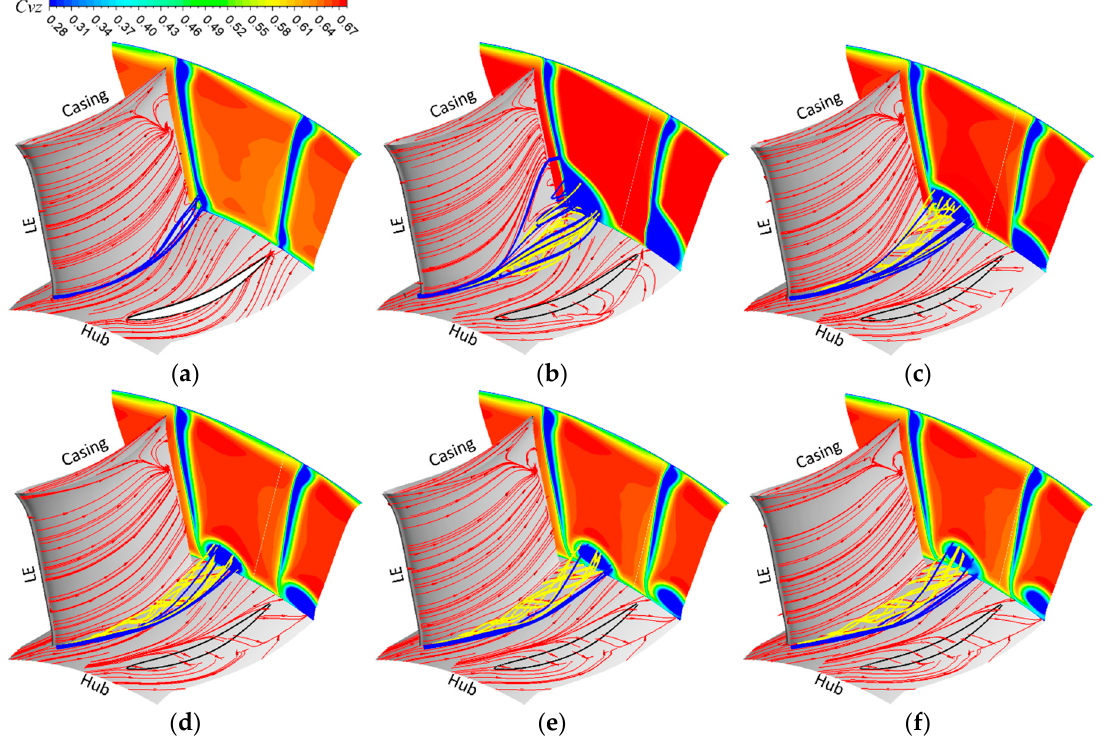
Figure 9. Three-dimensional flow structures inside the stator passage in the DE condition. ( a ) 0.00 τ , ( b ) 0.25 τ , ( c ) 0.50 τ , ( d ) 1.00 τ , ( e ) 1.50 τ , ( f ) 2.00 τ .